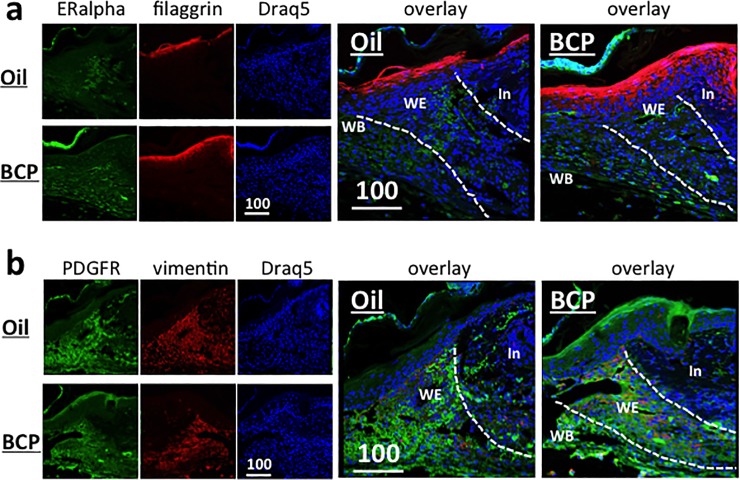
Expression of filaggrin (red) and estrogen alpha (green) (a), and PDGFR (green) and vimentin (red) (b) in the wounded area of mice. (a) View at the wound edge. In: intact area, WE: wound edge, WB: wound bed. Scale bar is in μm. Dotted lines show the boundaries between the intact area and wound edge, and the wound edge and wound bed. Filaggrin staining of the BCP group was broader in width and longer in the distance from the wound edge. Estrogen alpha staining did not show obvious differences between groups. (b) PDGFR expression in the epidermis was stronger in the BCP group. Both the BCP and Oil group showed a large area of staining of PDGFR in the wound edge (WE) and wound bed (WB). Vementin staining did not show obvious differences between the BCP group and Oil group. In: intact area, WE: wound edge, WB: wound bed. Scale bars are in μm.